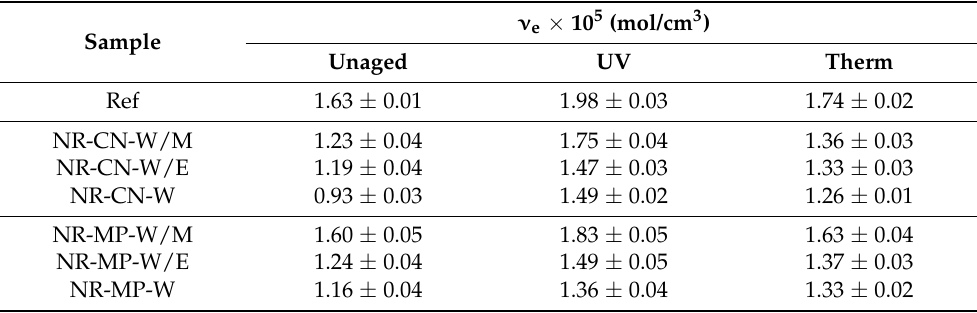
Table 6. Results of the cross–linking density ( ν e ) before degradation process (Unaged) and after ultraviolet (UV) and thermo-oxidative (Therm)